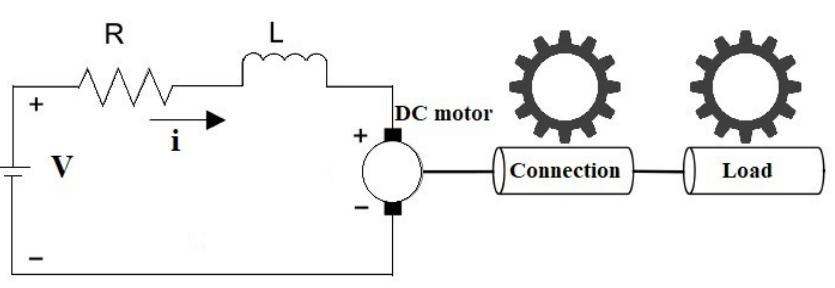
Figure 4. Diagram of DC motor